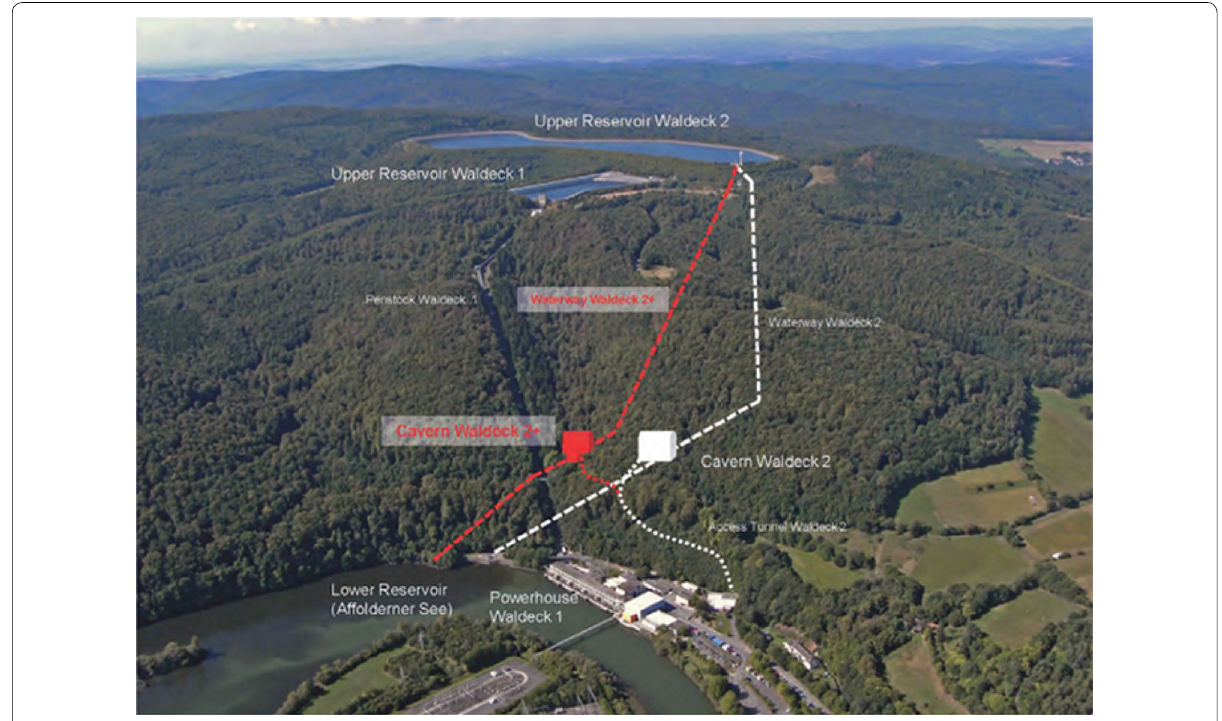
Fig. 3 PSHPP of Attaqa Mountain,